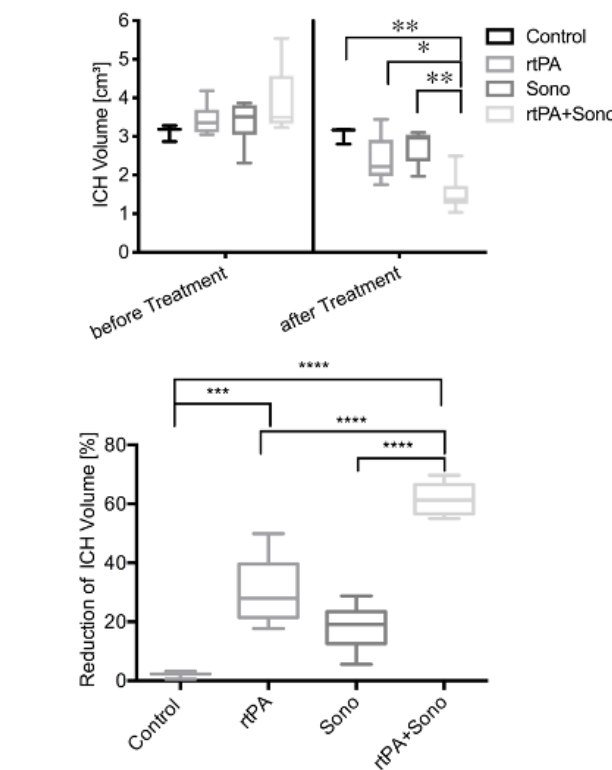
Figure 2. ( a ) Hematoma volumes ( y -axis) [cm³] are illustrated as box plots before and after treatments ( x -axis). ** marks the significant volume difference after treatment of the rtPA- and sono-treated group and the control group of p = 0.002 and between the ultrasound-treated group and the combined treatment group of p = 0.0023. * marks the significant volume difference after therapy between the group with the combined treatment and the group treated with rtPA of p = 0.0278. ( b) Relative hematoma volume reduction after treatment ( y -axis) [%] of the different groups ( x -axis) is shown using box plots. **** marks the significant hematoma volume reduction in group 4 of p < 0.0001. *** marks the significant volume reduction in group 2 compared to group 1 of p =